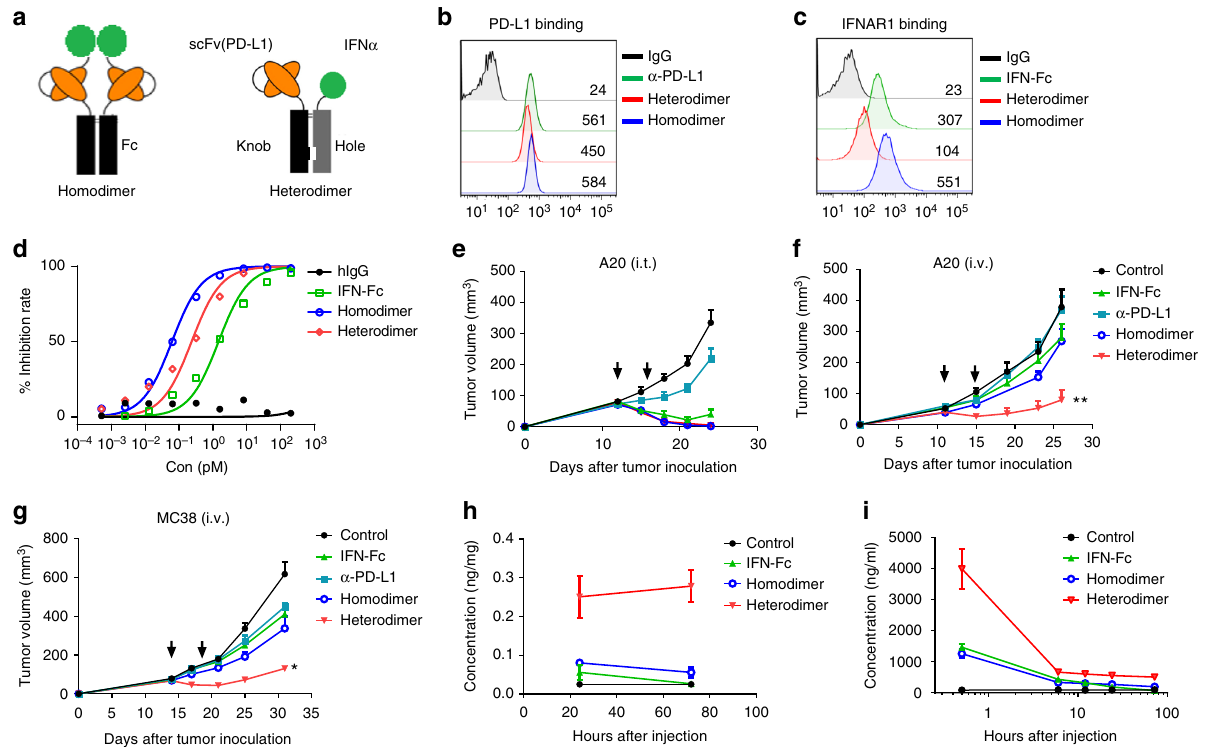
Fig. 2 Construction and characterization of IFN α -armed anti-PD-L1. a Schematic representations of IFN α -anti-PD-L1 fusion protein in homodimer or heterodimer format. scFv, single-chain variable fragment. b – c Flow cytometry histograms showing the binding of indicated protein in IFNAR1 -/- A20 cells ( b ) and PD-L1 -/- A20 cells ( c ) at the concentration of 80nM. Numbers indicate the mean fl uorescent intensity (MFI). d The bioactivity of IFN α -anti-PD-L1 protein was measured by an anti-viral infection biological assay. L929 cells were cultured with each protein overnight before being infected with VSV-GFP virus. After another 30h of culture, the percentage of virus-infected cells was determined by fl ow cytometry. e , f Balb/c mice ( n = 5) were inoculated with 3×10 6 A20 cells. After tumor established, mice were treated with 20 µ g of control, anti-PD-L1, IFN α -Fc, or fusion protein by i.t. ( e ) or i.v. ( f , day 11 and 15) injection. Tumor size was measured twice per week. g C57BL/6 mice ( n = 4 – 8) were inoculated with 5×10 5 MC38 cells. Mice were treated i.v. with 25 µ g control or fusion protein on days 14 and 18. h , i Mice were injected i.v. with 25 µ g indicated protein. Protein concentrations in tumor tissues ( h ) or serum ( i ) at different time points were measured by ELISA. Data indicate mean±SEM and are representative of at least two independent experiments. * p <0.05; ** p